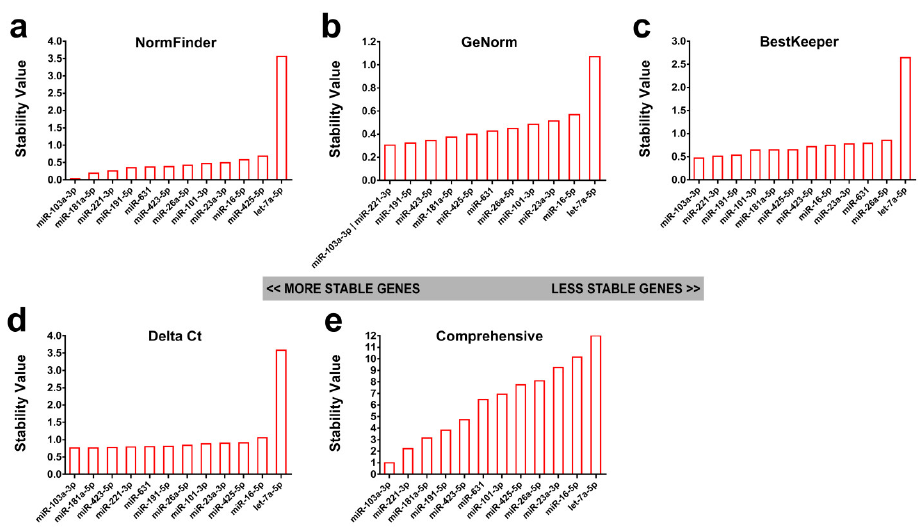
Figure 1. Identification of candidate reference genes (RGs) from Real-Time Quantitative Reverse